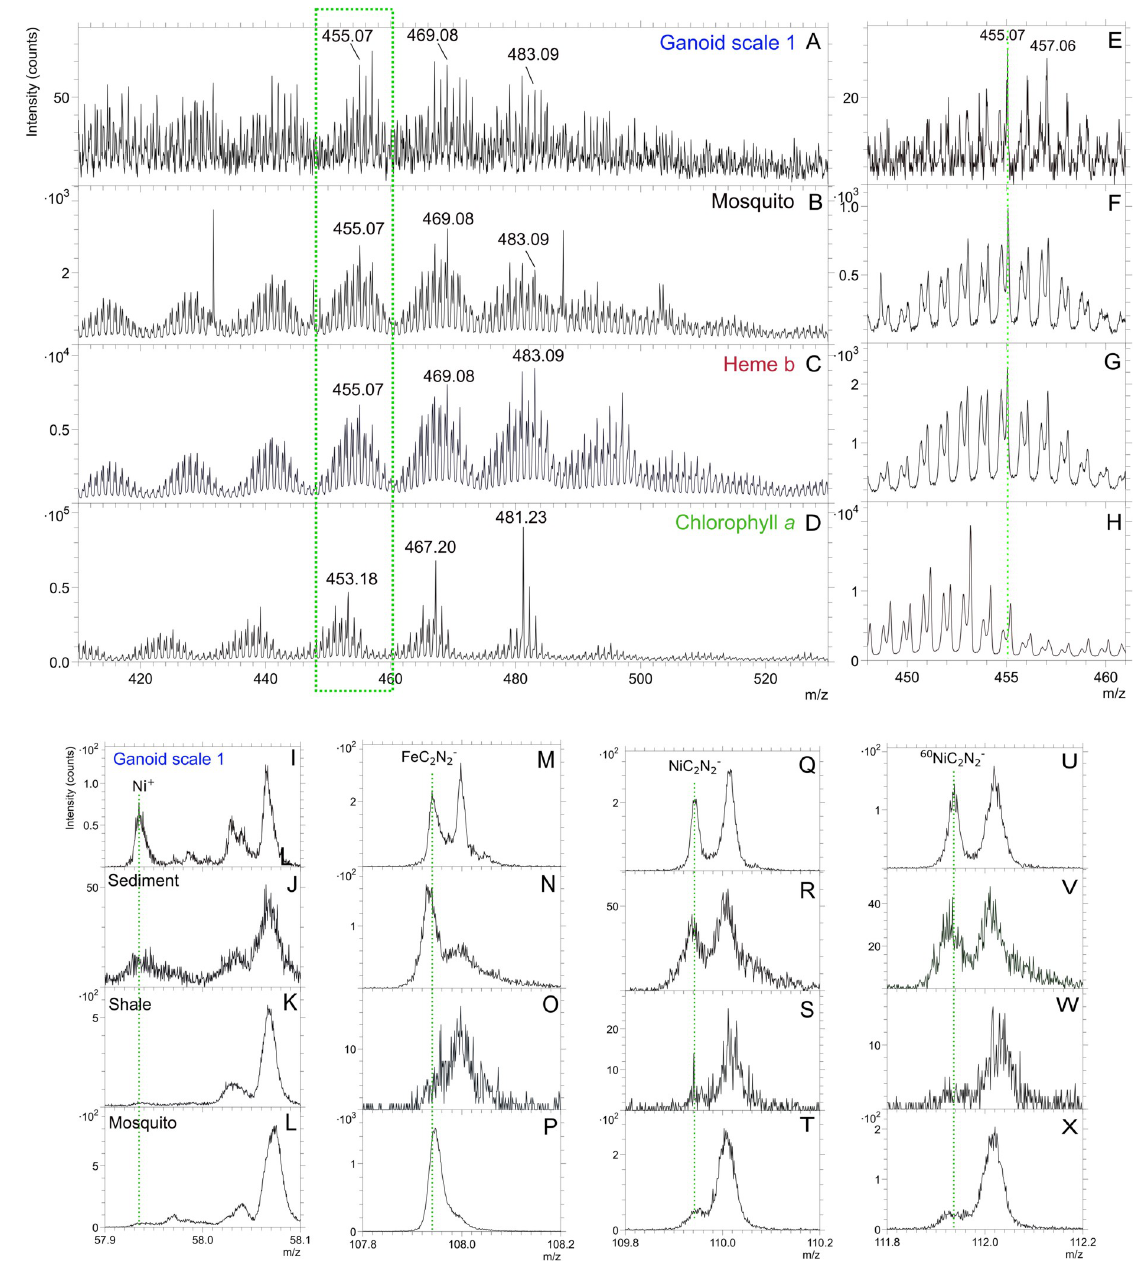
Fig 3. Molecular characterization of gray-brown film on Messel fossil scale by ToF-SIMS indicating diagenetically altered porphyrins. Positive ToF-SIMS spectra (m/z 410–530) of A) area indicated by green dotted box on ganoid scale 1 in Fig 1B, B) mosquito, C) heme b standard and D) chlorophyll a standard. E-H) Zoom-in of green dotted box in spectra in A-D showing m/z 448–461. ToF-SIMS spectra of fish scale with gray-brown film (I, M, Q, U), sediment attached to scale (J, N, R, V), shale sample collected nearby (K, O, S, W) and mosquito (L, P, T, X) showing Ni + (m/z 57.94), FeC 2 N 2- (m/z 107.94), NiC 2 N 2- (m/z 109.94) and 60 NiC 2 N 2- (m/z